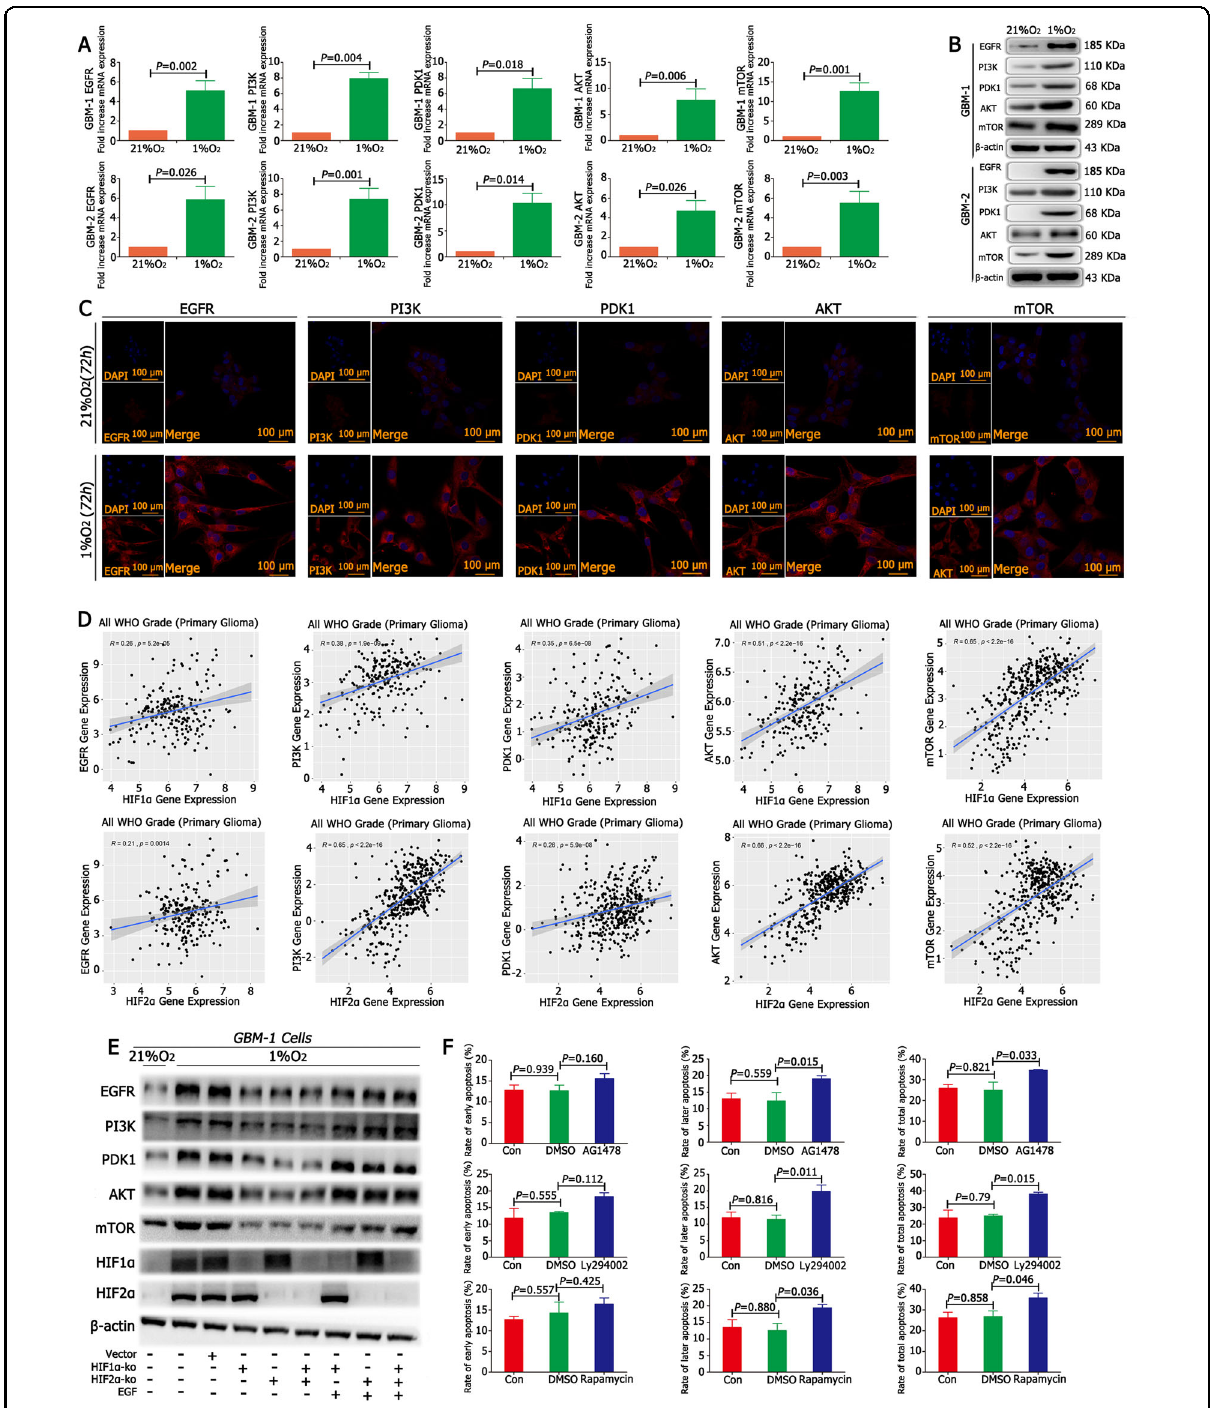
Fig. 4 HIF1 α /HIF2 α -EGF regulated GBM malignancy via the EGFR – PI3K/AKT pathway in hypoxia. A There was a higher expression of EGFR, PI3K, PDK1, AKT and mTOR in cells cultured in 1% O 2 than cells cultured in control conditions. B , C The cells cultured in 1% O 2 for 72 h highly expressed EGFR, PI3K, PDK1, AKT and mTOR, but there was much less expression of EGFR, PI3K, PDK1, AKT and mTOR under normoxic conditions. D Both HIF1 α and HIF2 α had a positive correlation with EGFR, PI3K, PDK1, AKT and mTOR. E A signi fi cant decrease in the expression of EGFR, PI3K, PDK1, AKT and mTOR in HIF1 α -KO or HIF2 α -KO cells. The addition of EGF into the culture medium of HIF1 α -KO or HIF2 α -KO cells showed an immediate recovery of the expression of EGFR, PI3K, PDK1, AKT, mTOR and HIF1 α . F Adding the EGFR inhibitor (AG1478), PI3K inhibitor (Ly294002) and mTOR inhibitor (rapamycin) into the culture medium of GBM cells in 1% O 2 showed that there were no signi fi cant differences for early apoptosis; however, there were higher late and total apoptosis rates. P values were determined by the independent samples t test and one-way